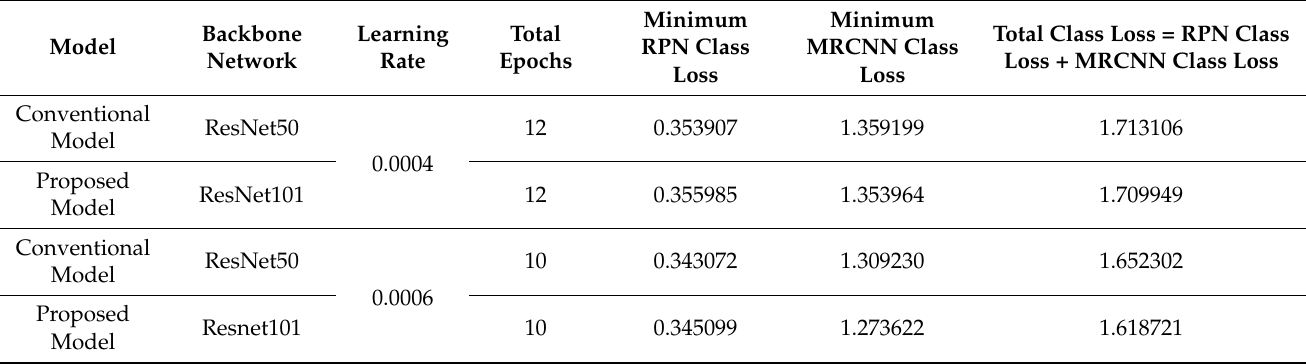
Table 7. Class loss values for validation data with different learning rates and epochs.